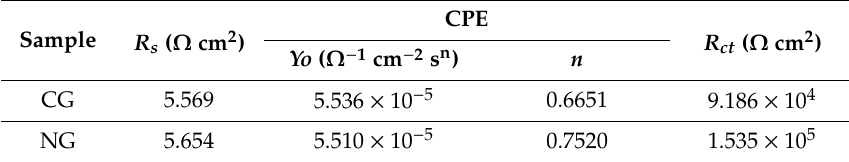
Table 2. Equivalent circuit results obtained from electrochemical impedance spectroscopy (EIS) data fitting.